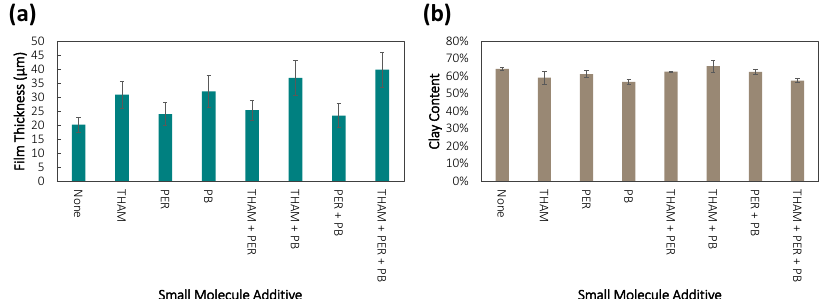
Fig. 2 Film growth. a Thickness of 14 BL PEI/VMT fi lms with varying additive(s) and b clay content of fi lms, measured using thermogravimetric analysis. Error bars are standard